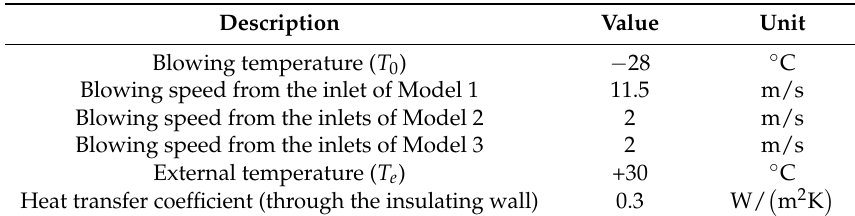
Table 1. Boundary conditions used for turbulence